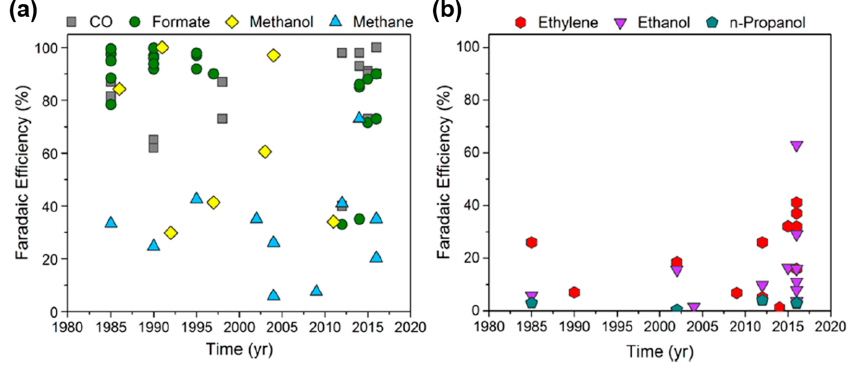
Figure 2. Faradaic efficiency records classified by year for ( a ) C 1 products and ( b ) C 2 –C 3